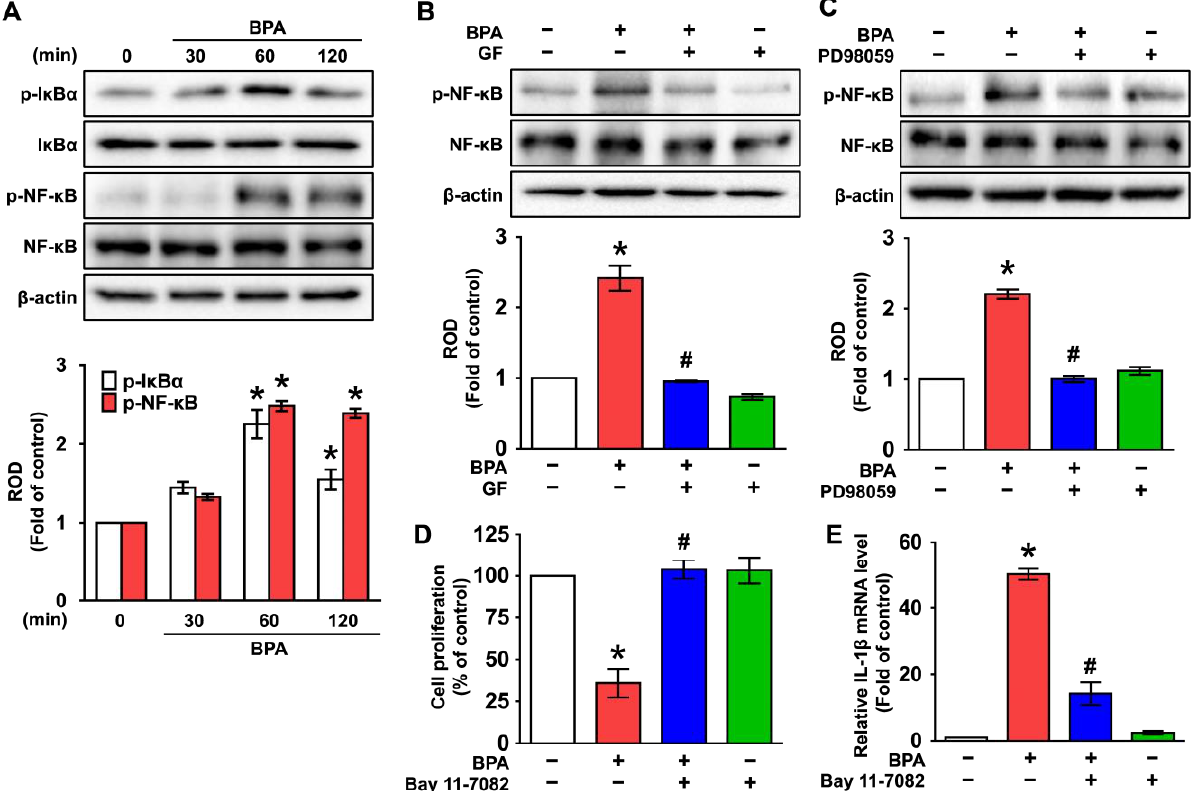
Figure 5. GF inhibits the NF- κB activation to regulate the IL - 1β expression triggered by BPA. ( A ) Time-dependent responses of activation of I κ B α and NF- κ B in NHDFs exposed by BPA are shown. n = 3. * p ≤ 0.05 vs. 0 min. ROD, relative optical density. ( B ) The inhibitory effect of GF on activation of NF- κB in BPA -treated NHDFs is shown. n = 4. * p ≤ 0.05 vs. Cont., # p ≤ 0.05 vs. BPA alone. ( C )